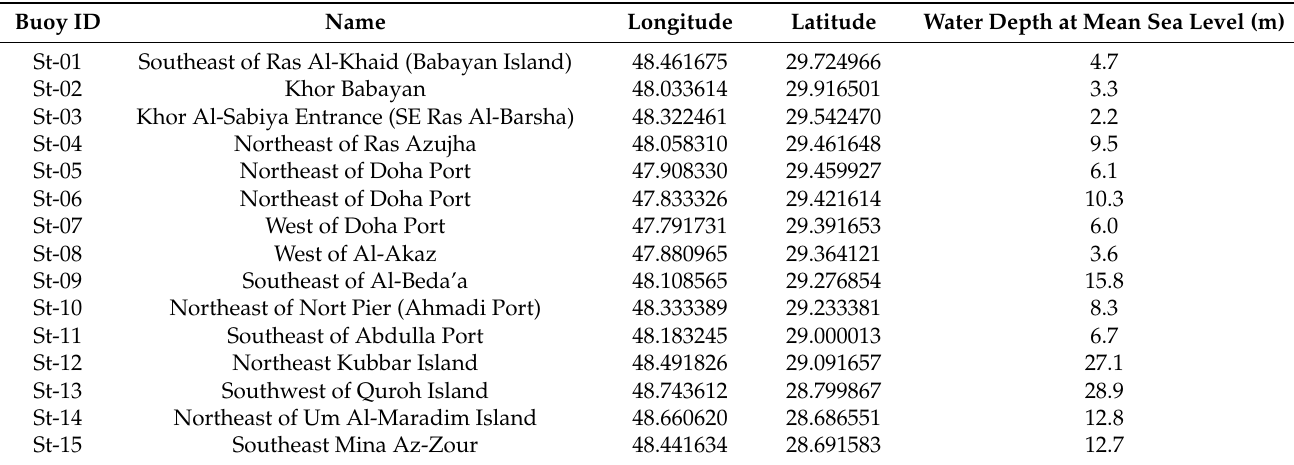
Table 1. Station names and coordinates.